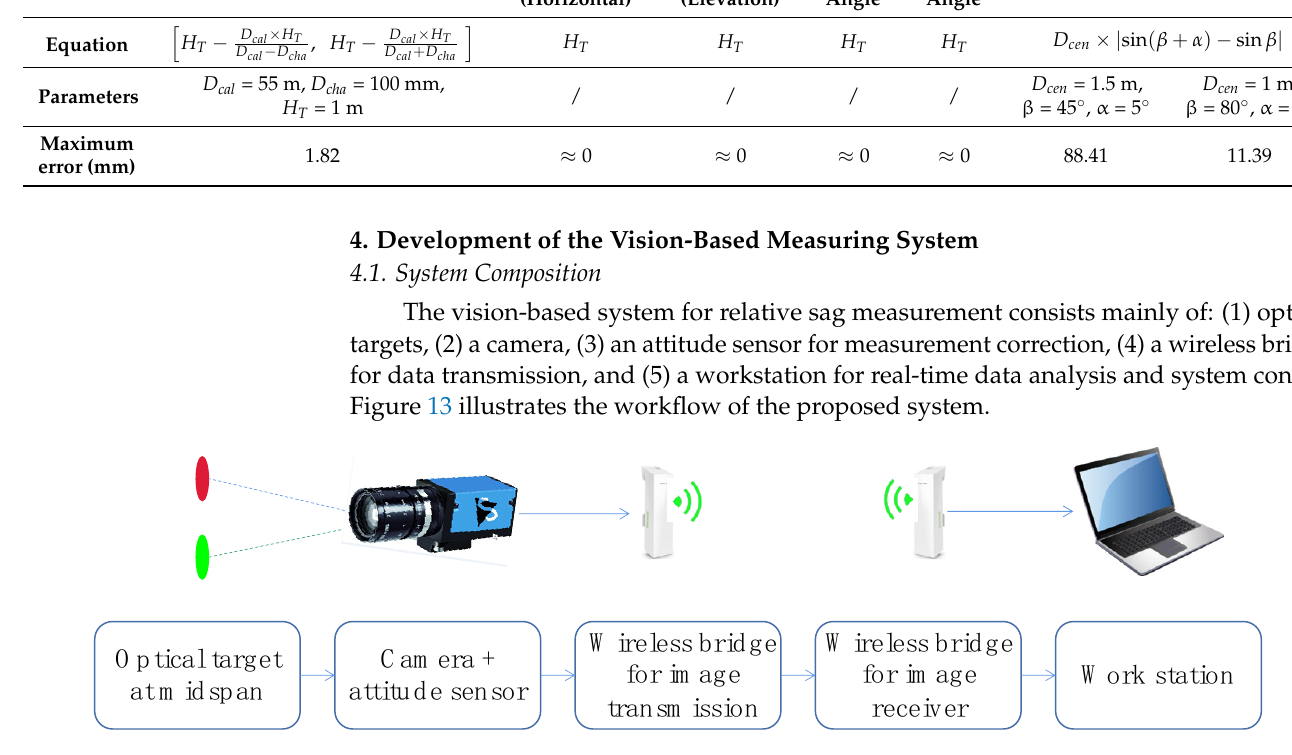
Figure 13. Vision-based system for relative sag measurement.